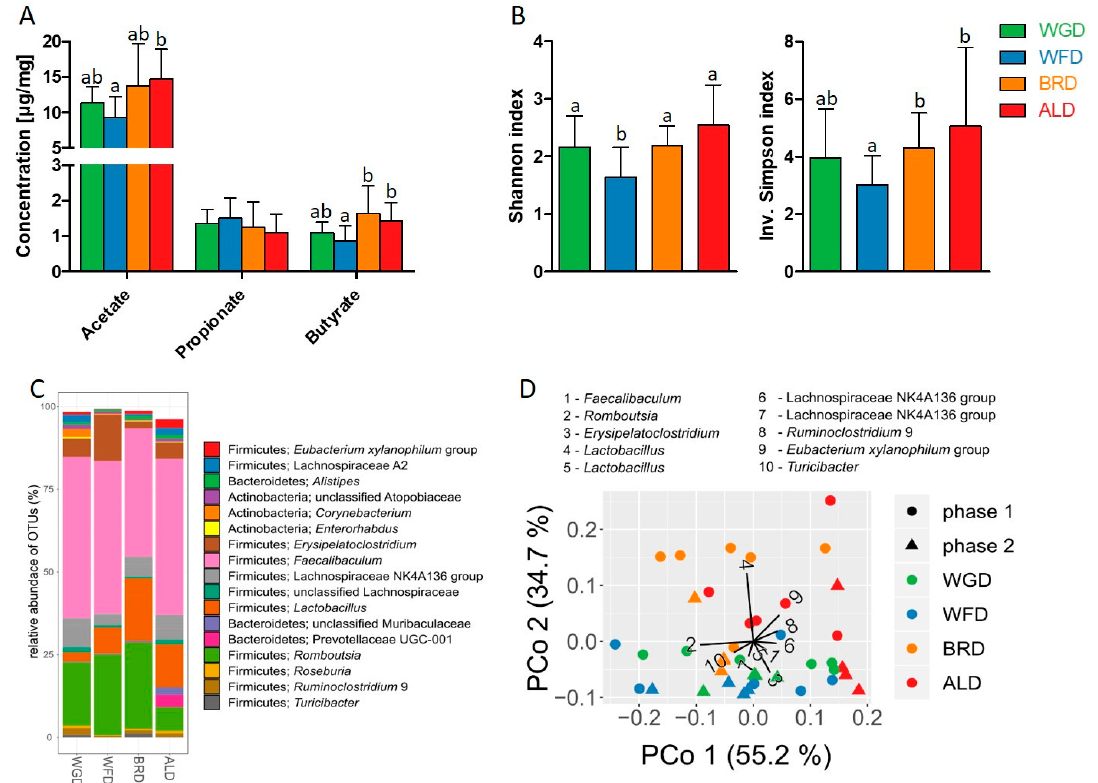
Figure 4. Effect of the different grain fractions on cecal SCFA concentrations ( A ), microbial α -diversity delineated as Shannon and inverse Simpson indices ( B ), average relative abundance of microbial genera ( C ), and microbial β -diversity ( D ) demonstrated using principal coordinates analysis (PCoA) based on Jensen–Shannon-divergence (JSD). Each data point represents an individual mouse with the experimental phase and diet group indicated by the shape and color, as specified in the legend. Black lines indicate the contribution (“loadings”) of each OTU to the principal coordinates. Percentages indicate the fraction of total variance explained by the respective principal coordinate. For bar diagrams: Values shown are means ± SD. a, b marked bars without a common letter differ significantly ( p < 0.05).